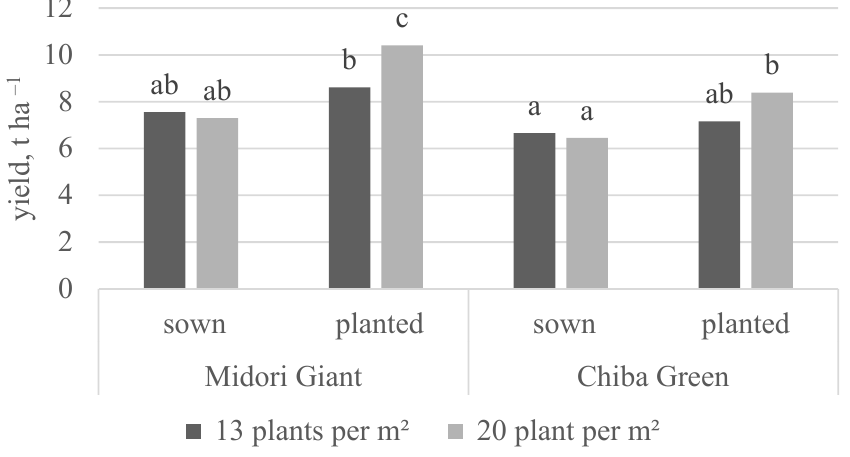
Figure 3. Vegetable soybean fresh pod yield in 2017, in Latvia. n = 2. Values marked by different letters have significant difference (Duncan’s criteria, p < 0.05).